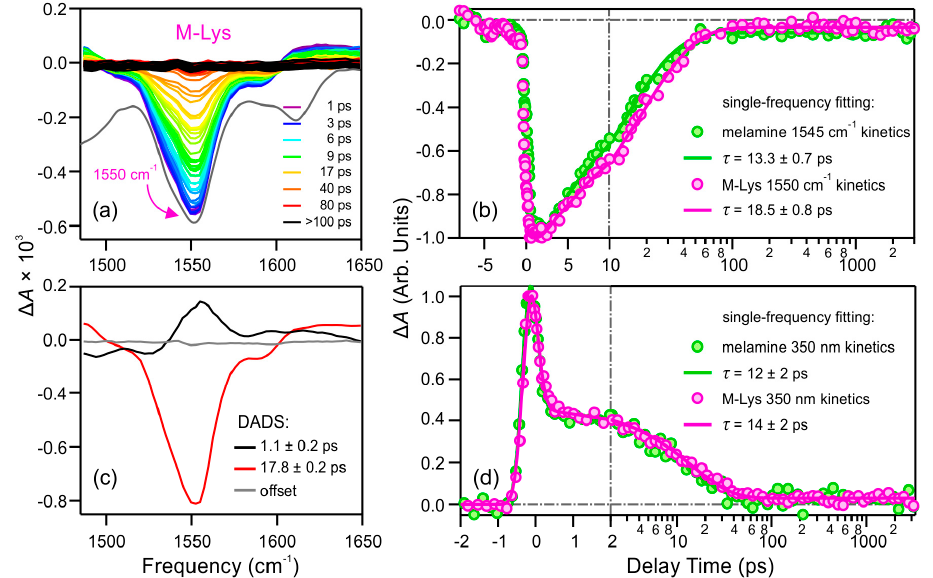
Figure 5. ( a ) TRIR spectra of M-Lys in neutral D 2 O solution recorded from 1 ps ( purple ) to 3 ns ( black ) after 240 nm excitation. The inverted FTIR spectrum ( gray ) is shown for comparison. The magenta curved arrow points to the frequency of the kinetic traces presented in panel ( b ); ( b ) Normalized bleach recovery kinetic trace for M-Lys (magenta) and the unsubstituted melamine (green); ( c ) Decay-associated difference spectra (DADS) for M-Lys obtained from global fitting; ( d ) Normalized excited-state decay of M-Lys (magenta) and the unsubstituted melamine in neutral D 2 O solution probed at 350 nm after 240 nm excitation. The points are normalized experimental data. The solid lines are the best-fit curves (see caption for Figures 3 and 4). The original data (without normalization) for the unsubstituted melamine have been shown in Figures 3b and 4a. The vertical dash-dotted lines mark the linear-logarithmic break. The time constants obtained from single-frequency and global fitting are included. The uncertainties reported are 2 σ .